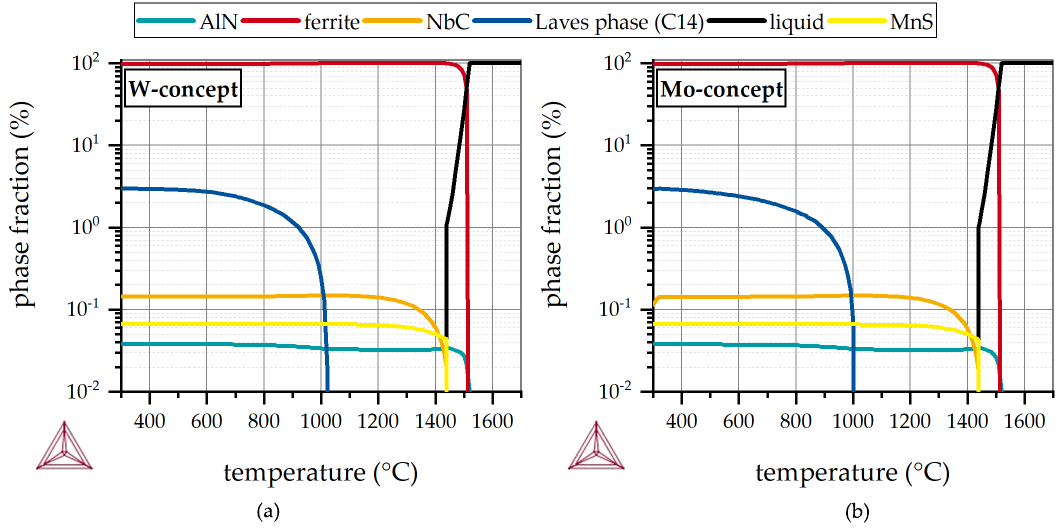
Figure 2. Results of the thermodynamic simulations for W- ( a ) and Mo-concept ( b ) using T HERMO C ALC with database